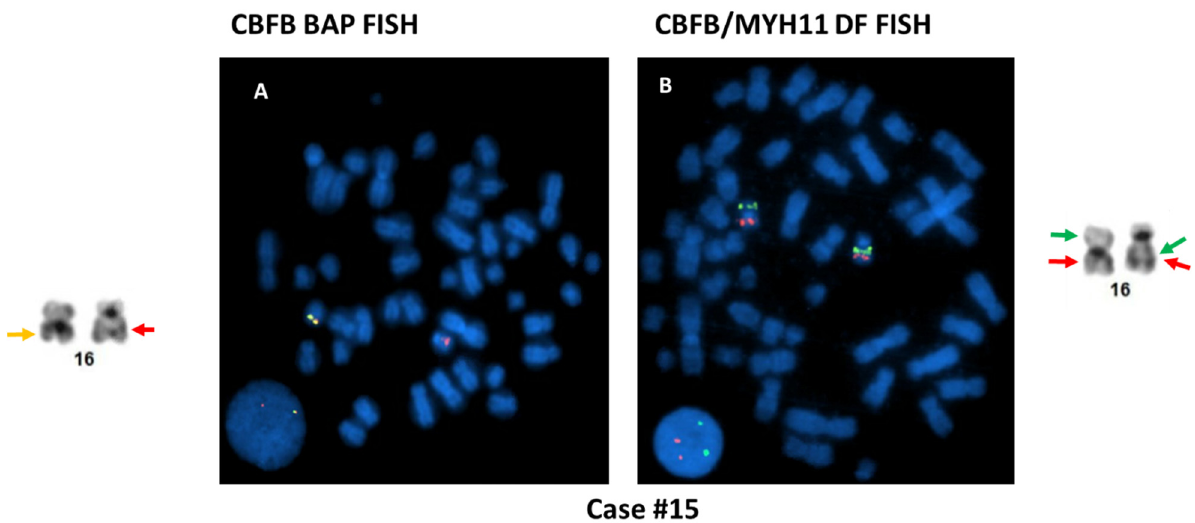
Figure 5. Illustration of case #15 with inv(16) and an additional chromosomal 16 abnormality. An atypical FISH signal pattern (1R1F, A ) was detected by BAP FISH. However, no CBFB-MYH11 fusion signal was detected by DF FISH ( B ), though the metaphase image indicated that the MYH11 was relocated on 16q (RT-PCR was also negative).